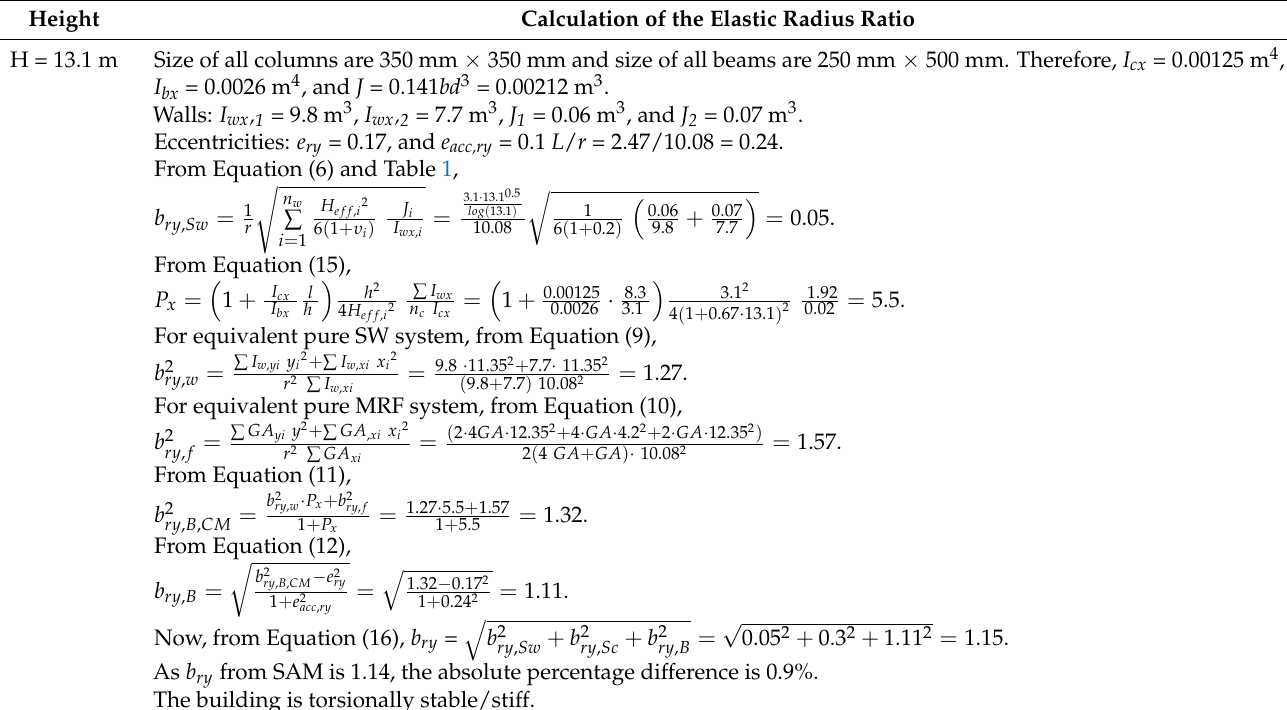
Table A2. Calculation of the Elastic Radius Ratio for Building Model ‘k’. Height Calculation of the Elastic Radius